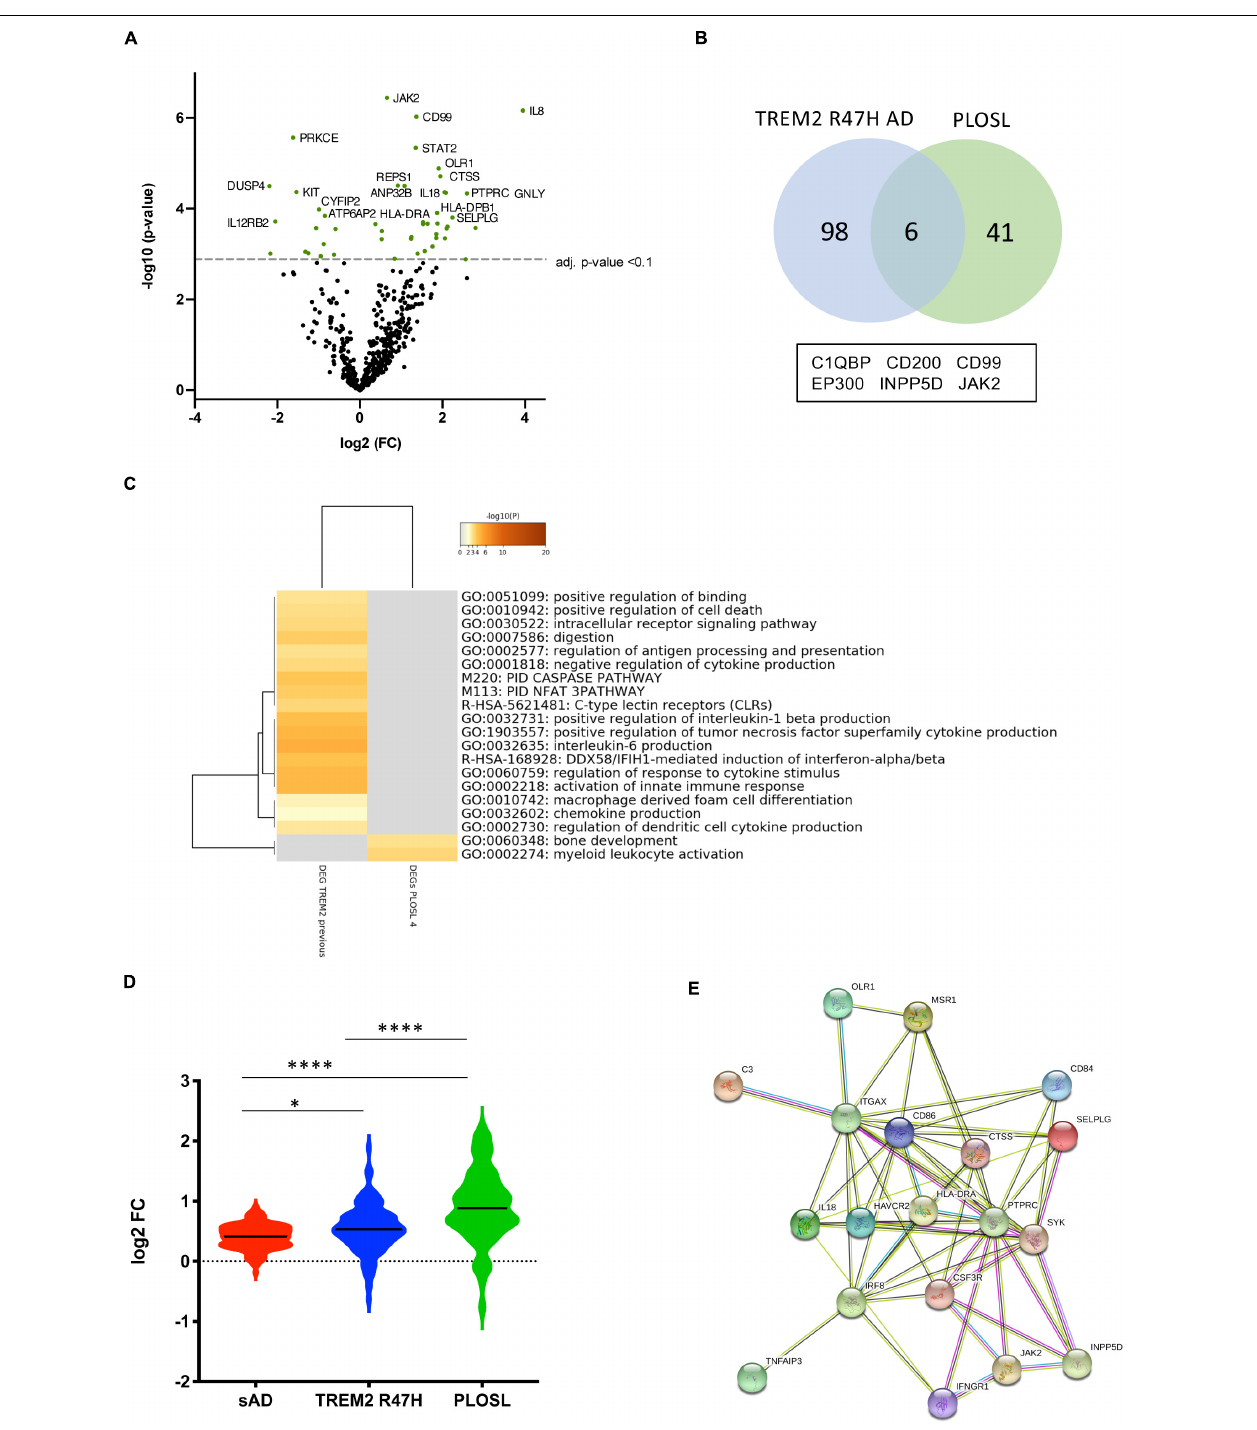
FIGURE 5 | Differentially expressed (DE) and microglia-specific genes in PLOSL. (A) Volcano plots displaying DE genes in PLOSL against a baseline of gene expression in controls. (B) Venn diagram and list of shared DE genes (FDR < 0.1) between TREM2 R47H AD and PLOSL. (C) Enriched ontology clusters in DE TREM2 R47H AD and PLOSL. Metascape cluster analysis of GO term enrichment among DE genes (FDR < 0.1) between TREM2 R47H AD and PLOSL. Eight hundred genes on the NanoString panel were used as a background for enrichment calculations. GO ID, Description: Representative GO term; Log10(P) – p -value for enrichment. (D) Microglia-specific genes (MG) expression is highly perturbed in PLOSL as compared with AD groups. Distribution of fold changes in MG ( N = 134); X -axis displays log2 of fold changes between gene expression in cases vs. controls ( ∗ p -value < 0.05; ∗∗∗∗ p -value < 0.0001, one-way ANOVA, Tukey’s multiple comparison test); (E) Protein–protein association network formed by differentially expressed MG in PLOSL, as visualized by STRING database (http:/string-db.org).